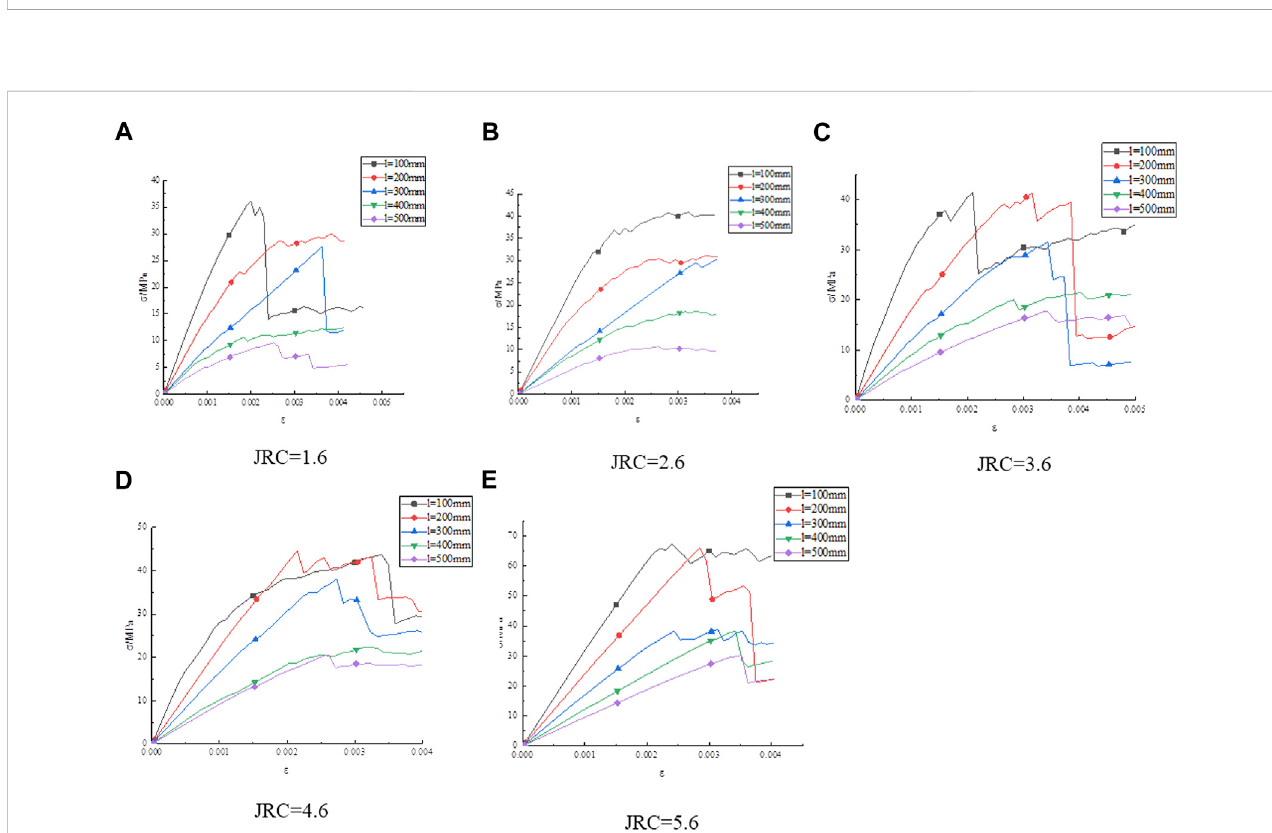
FIGURE 2 Stress-strain curves under different joint roughness coef fi